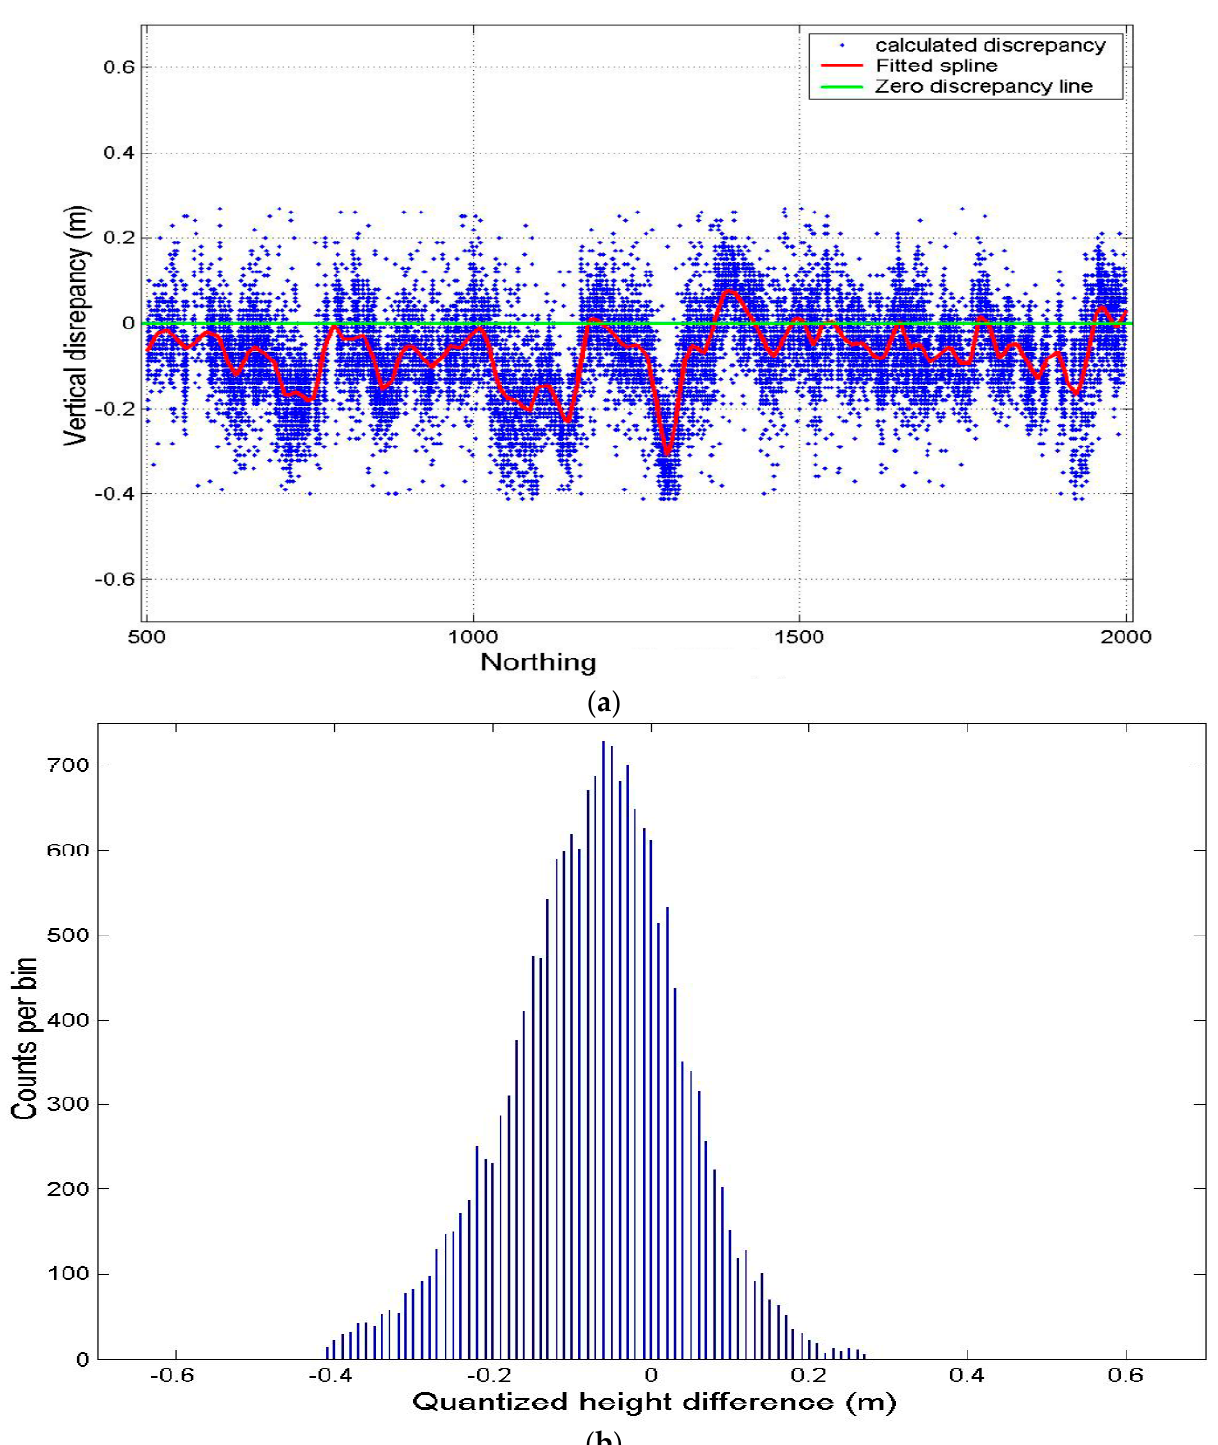
Figure 7. ( a ): Relative height discrepancy along the North–South direction in the overlap region between the 7th and the 8th strip. ( b ): The histogram of the relative height discrepancy between the 7th strip and the 8th strip.